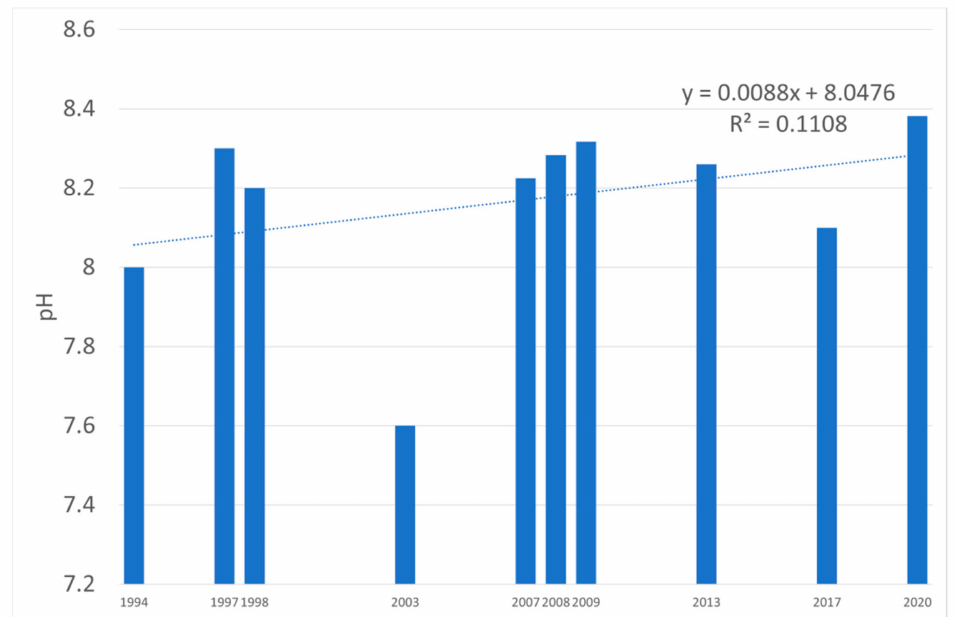
Figure 6. Changes in pH values and the trend line in the Vistula in the period from 1994 to 2020.